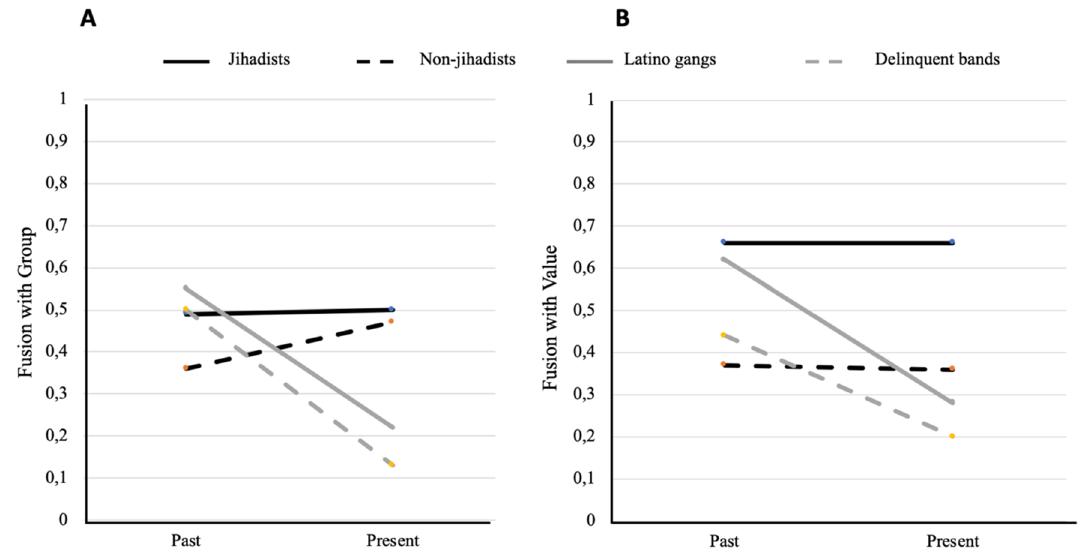
Figure 2. Prisoners’ perceived level of fusion with primary reference group ( A ) and value ( B ) over time (time of sentencing to present, average 56.28 months). Jihadists maintain, and non-jihadists increase, fusion with primary group (i.e., Muslims), whereas Latino gangs and delinquent bands decrease fusion with their primary criminal groups over time. Jihadist and non-jihadists maintain fusion with their primary value (i.e., religion), but jihadists show higher levels than non-jihadists, while gangs and bands show less fusion with value (i.e., honor) over time.